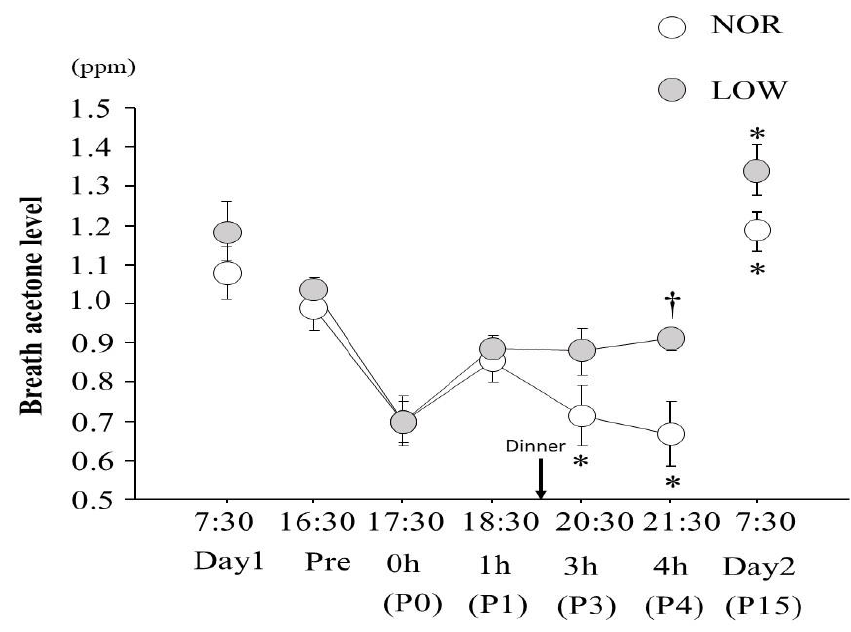
Figure 2. Changes in breath acetone level. Values are means ± SE.* p < 0.05 vs. 1 h, † p < 0.05 vs. trial. Figure2. Changes in breath acetone level. Values are means ± SE.* p < 0.05vs.1h, † p <0.05